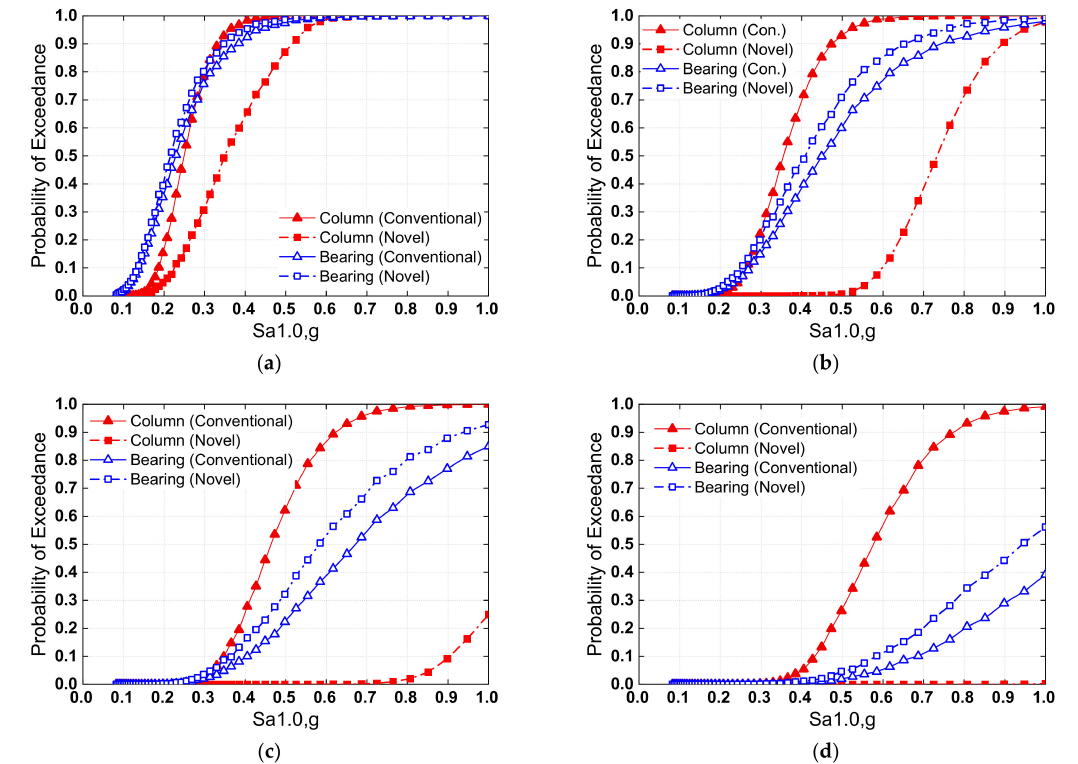
Figure 12. Component fragility for ( a ) slight damage, ( b ) moderate damage, ( c ) extensive damage, and ( d ) complete damage.